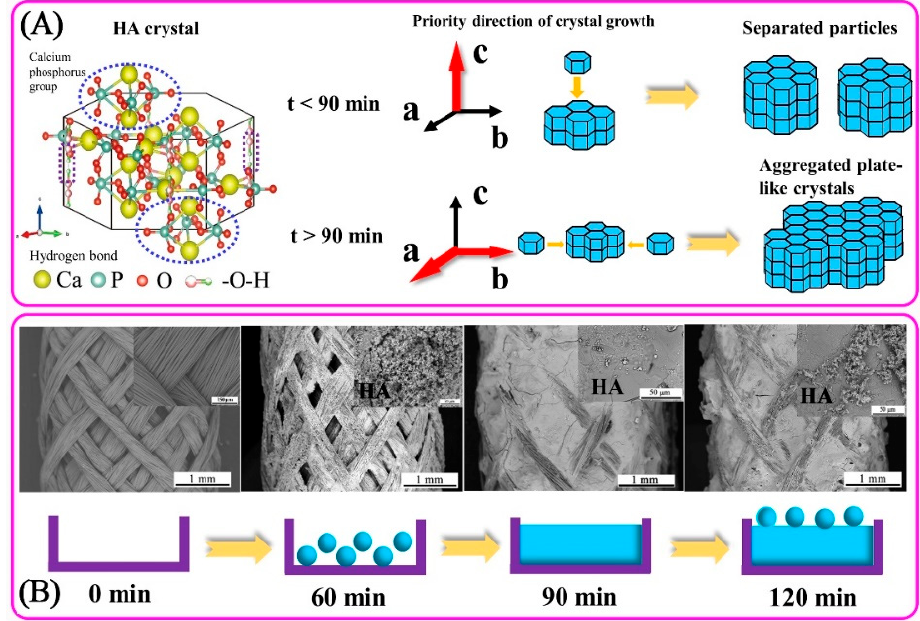
Figure 8. ( A ) The formation mechanism of granular and plate-like HA crystals during electrodeposition, in which the crystal structure of HA is drawn by Vesta 3.0 software and the red arrow is the preferred growth direction of HA crystal. ( B ) SEM images of braids at different deposition times and its simple models, in which the surface of braid can be simplified to a rectangle with a notch in the upper part before deposition (0 min).